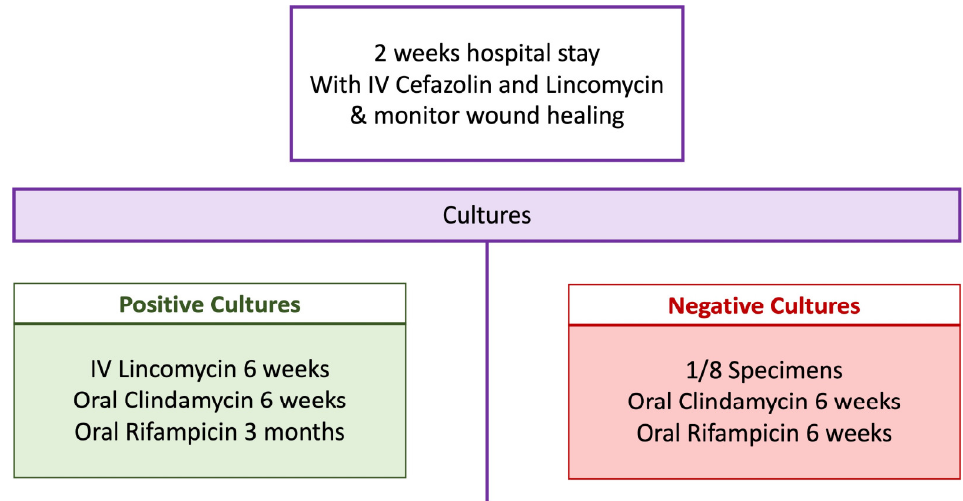
Figure 10. Postoperative antibiotic regimen.